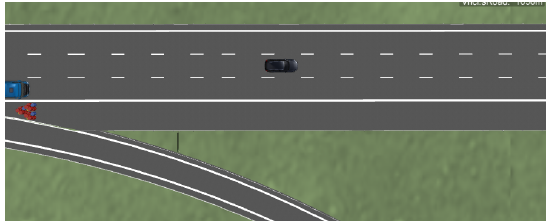
Figure 2. Snapshot of the junction in the test